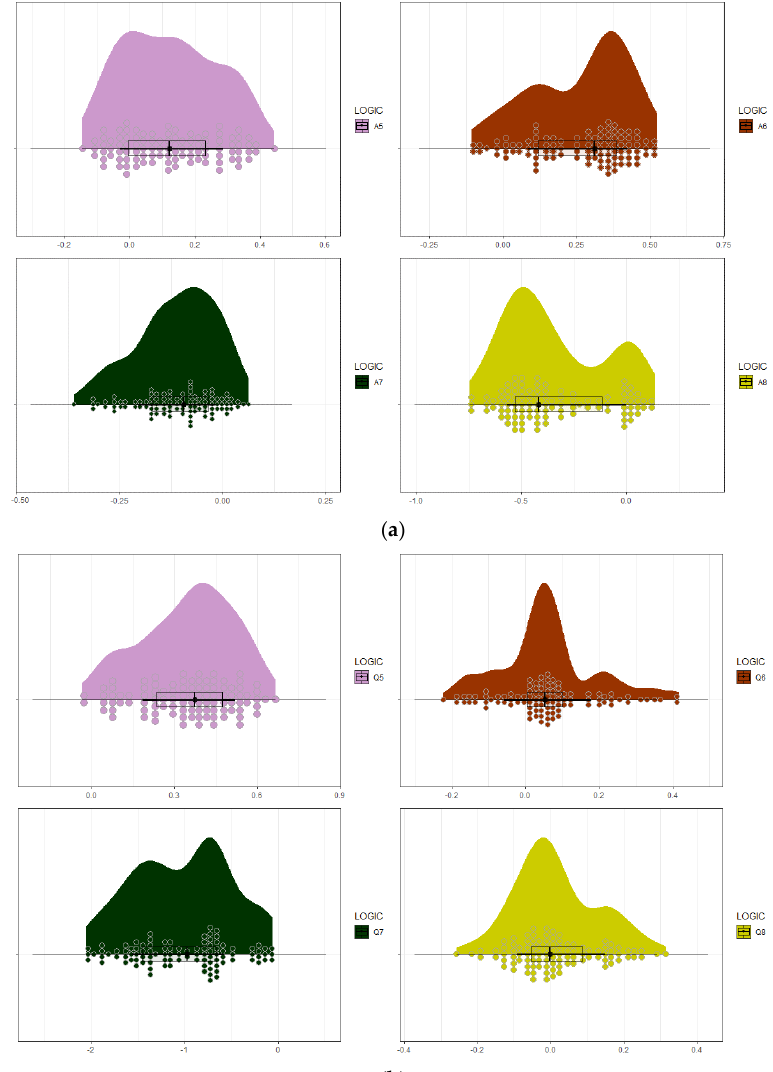
Figure 15. The Raincloud Plot analysis for ( a ) δ 1 2 SAT ρ , ( b ) δ 2 2 SAT ρ synaptic weight means when 0.7 Y = . Y = 0.8 Y =